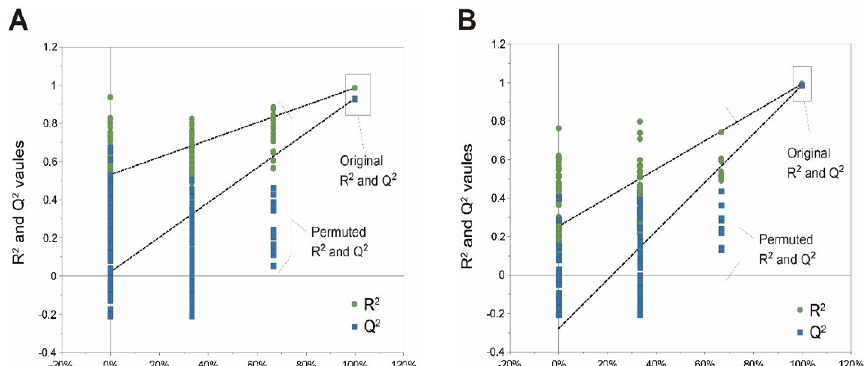
Figure 5. Permutation test in projections to latent structures-discriminant analysis (PLS-DA) models to validate OPLS-DA models. Correlation between original Y-vector and permuted Y-vector: ( A ) between KWA and KWK; ( B ) between KWK and UW given in Figure 3.